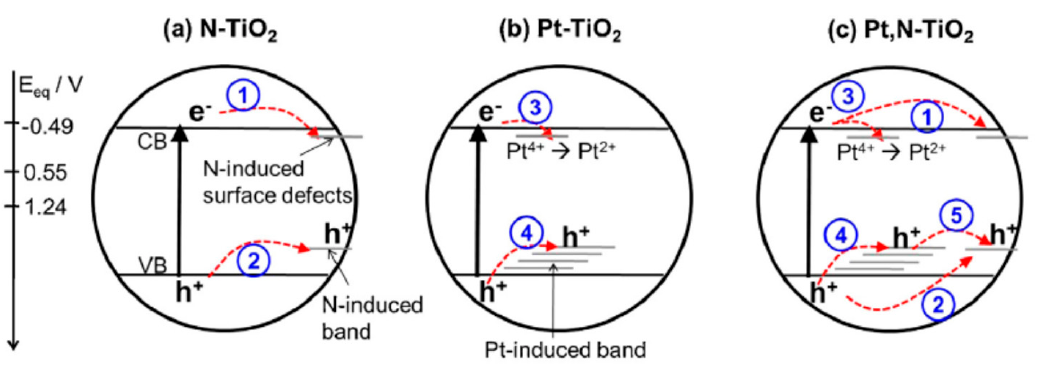
Figure 17. Schematic illustration for electron and hole trapping in ( a ) N-TiO 2 , ( b ) Pt-TiO 2 and ( c ) Pt,N-TiO 2 under 355 nm irradiation. The numbers refer to charge transfer steps: (1) electron trapping on the defect site, (2) hole trapping on the N-induced states, (3) intervalent charge transfer or transition of Pt 4+ to Pt 2+ , (4) localization of holes on the Pt-induced band and (5) hole-hopping. Reprinted from [74], Copyright 2020, with permission from Elsevier.